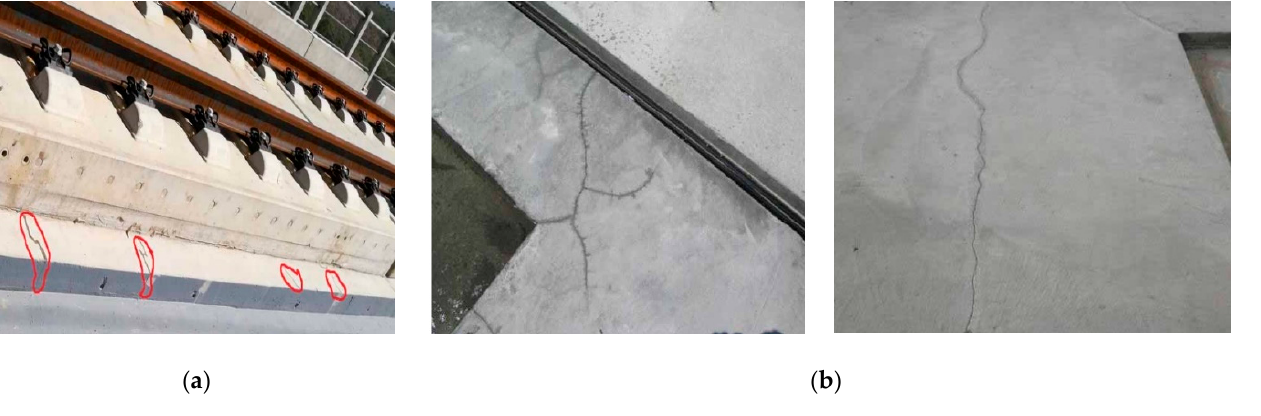
Figure 2. Cracking problem of CRTSIII SBT base. ( a ) Overall view of cracking; ( b ) cracking form 1.